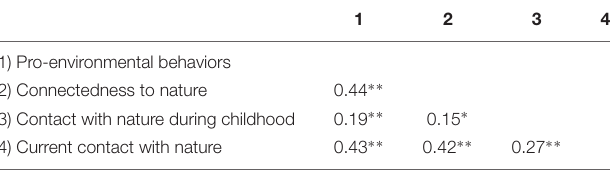
TABLE 2 | Correlations among the variables.